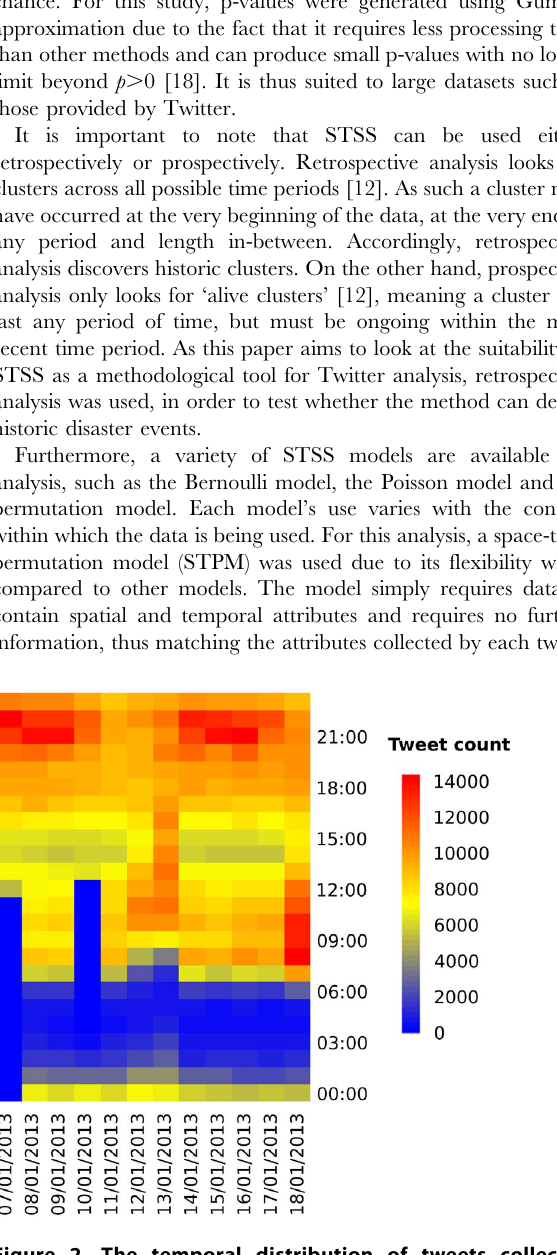
Figure 2. The temporal distribution of tweets collected between 7th January and 18th January 2013.